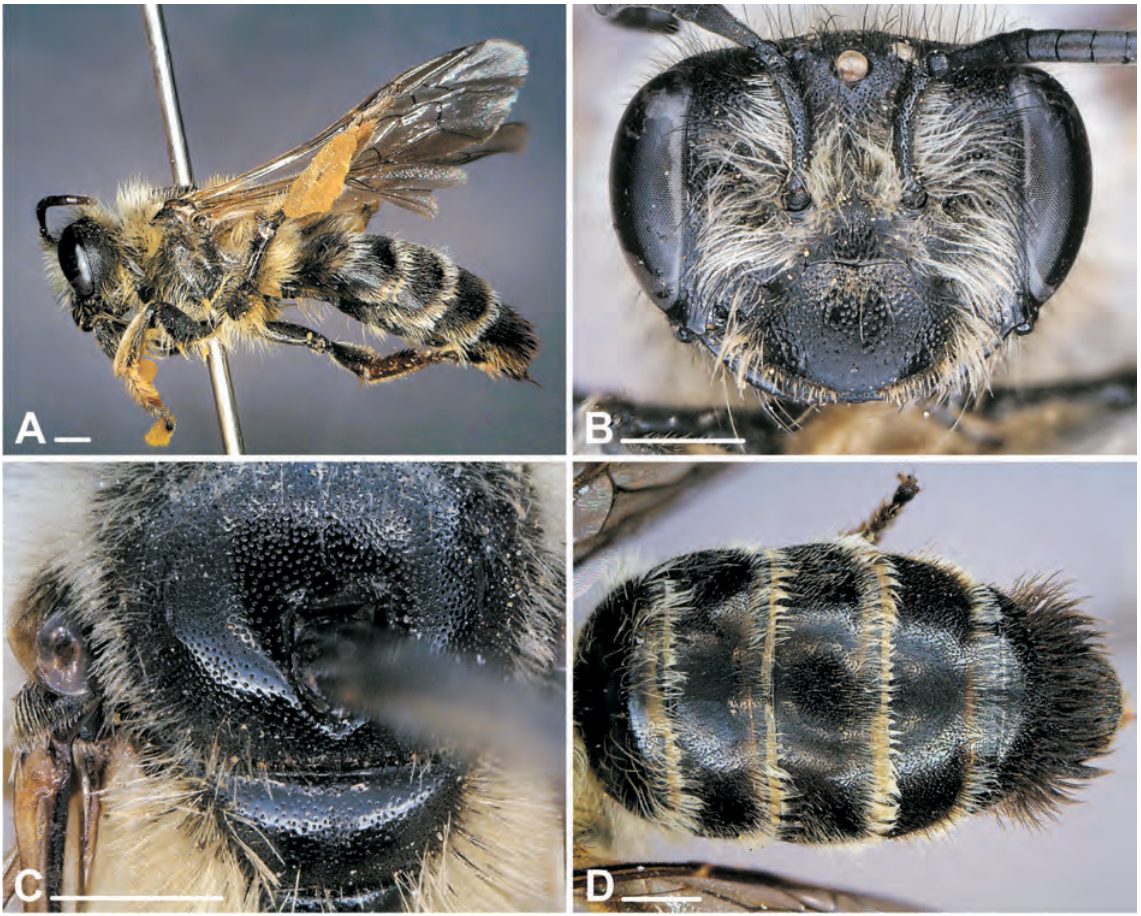
Fig. 5. Redivivoides eardleyi sp. nov., ♀. A . lateral view. B . head. C . Scutum and scutellum. D . Metasoma (dorsal view). Scale bar: 1